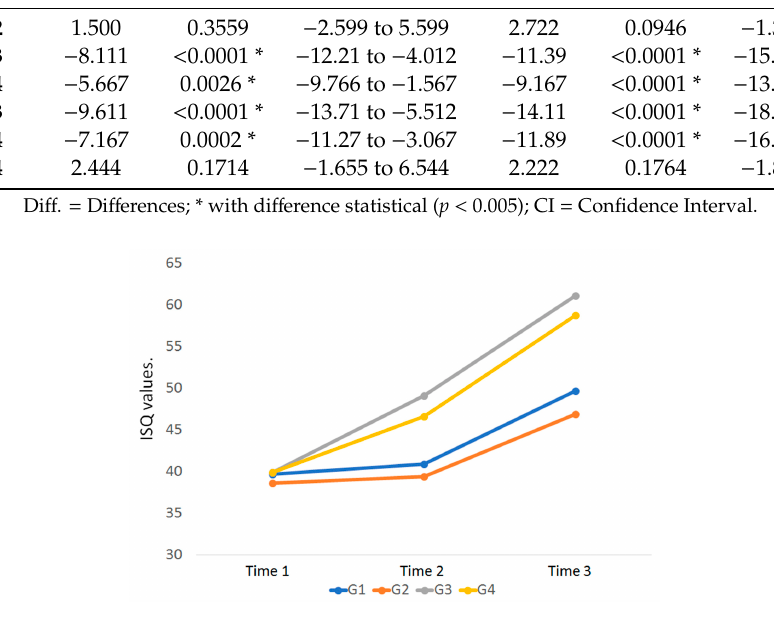
Figure 8. Line graph showing the ISQ evolution on the different times in each group. Time 1 = immediately at the installation; Time 2 = 15 days after the installation; Time 3 = 30 days after the installation.